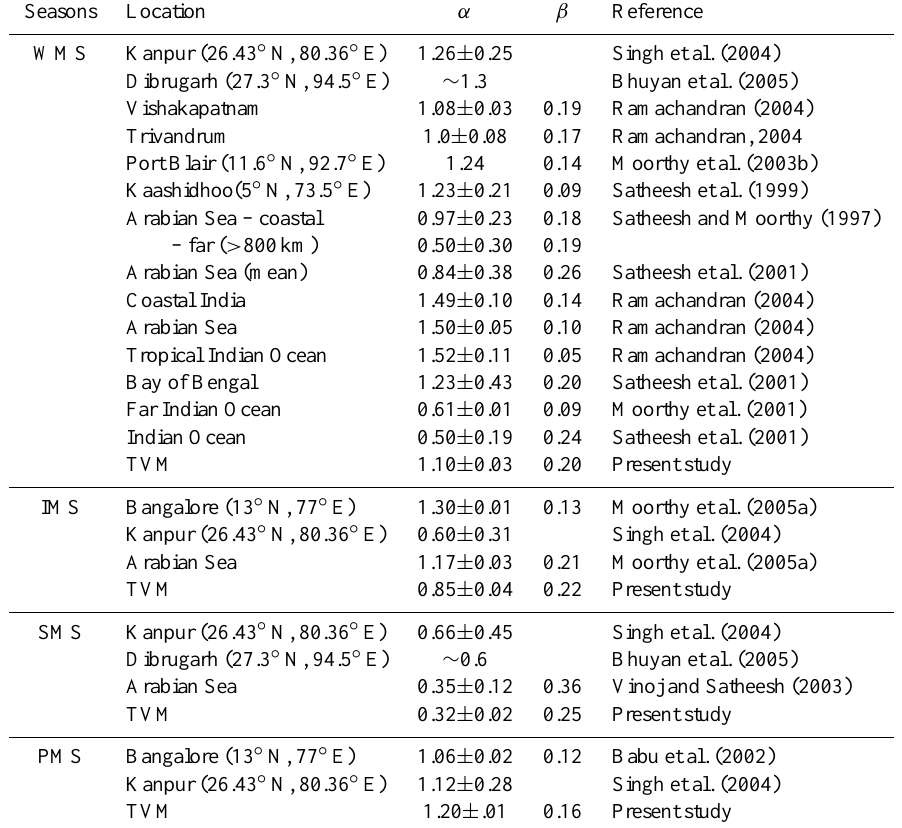
Table 3. ˚Angstr¨om parameters over various Indian locations as well as marine locations around India along with that observed during the present